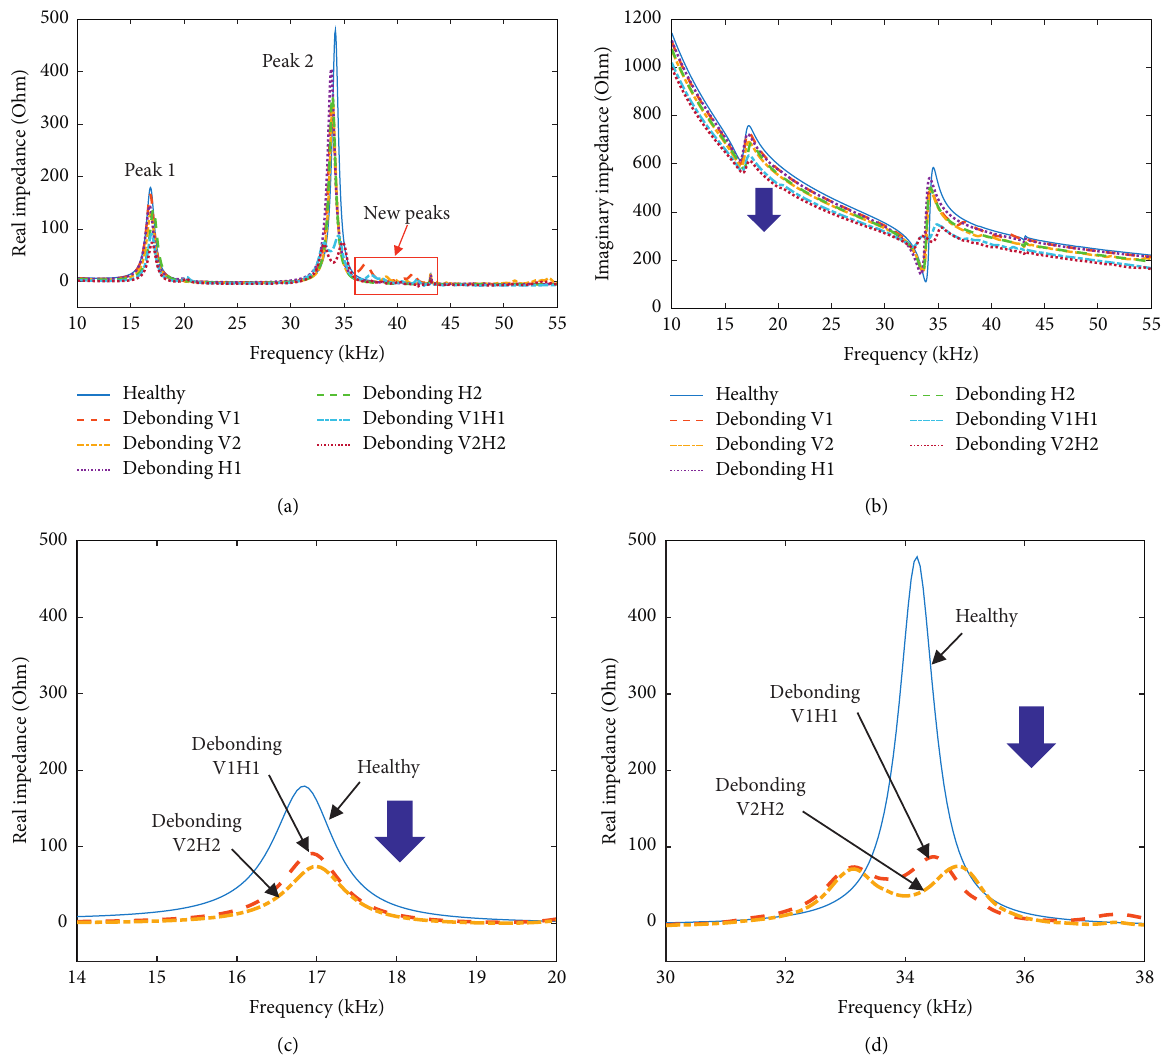
Figure 18: Numerical EMI responses under PZT debonding defects. (a) Real part. (b) Imaginary part. (c) Peak 1. (d) Peak